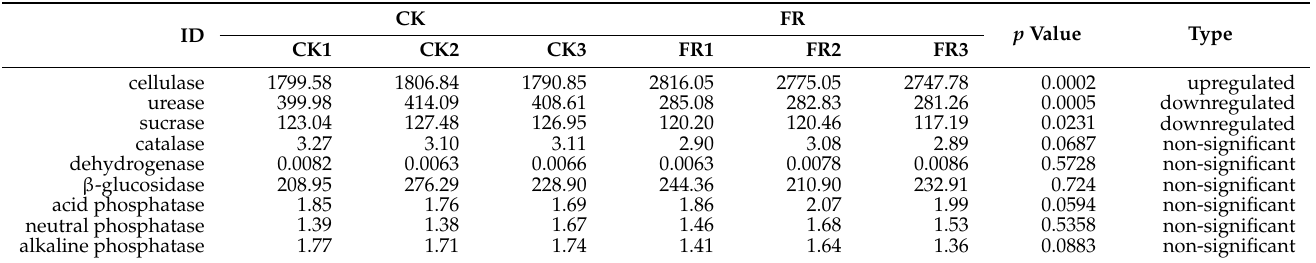
Table 2. Enzyme activities status of soils in FR compared with CK zones in a fairy ring ecosystem. The numbers mean